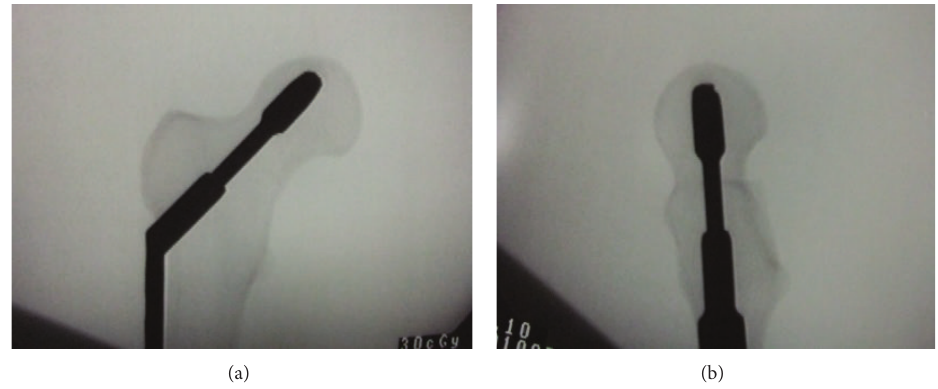
Figure 2: Implant at SC position under fluoroscopic guidance instrumentation.